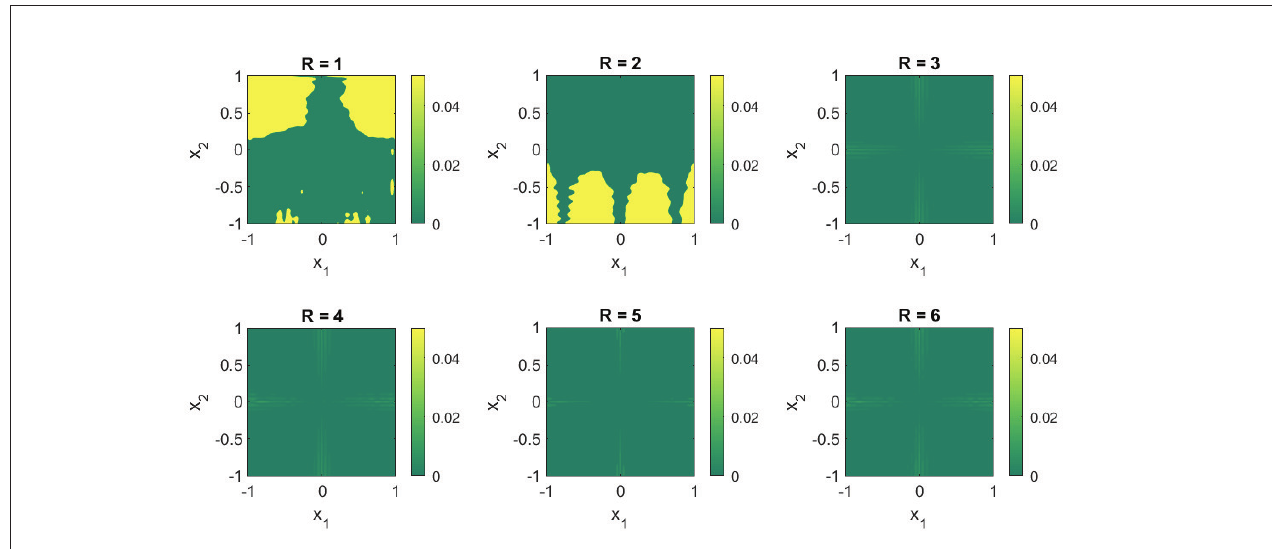
FIGURE 2 | A R 3 separable expansion is necessary to obtain a fit that is capable of capturing the global features of the function (Equation 19). We used 8,000 = random function samples for our training set. The fits were obtained with a B-spline basis comprising of a uniformly distributed knot set and M depict the absolute error between the true function (Equation 19) and the obtained approximation using (Equation 8). et al. (2019) and Vervliet et al. (2017); see Appendix A for the exact algorithmic